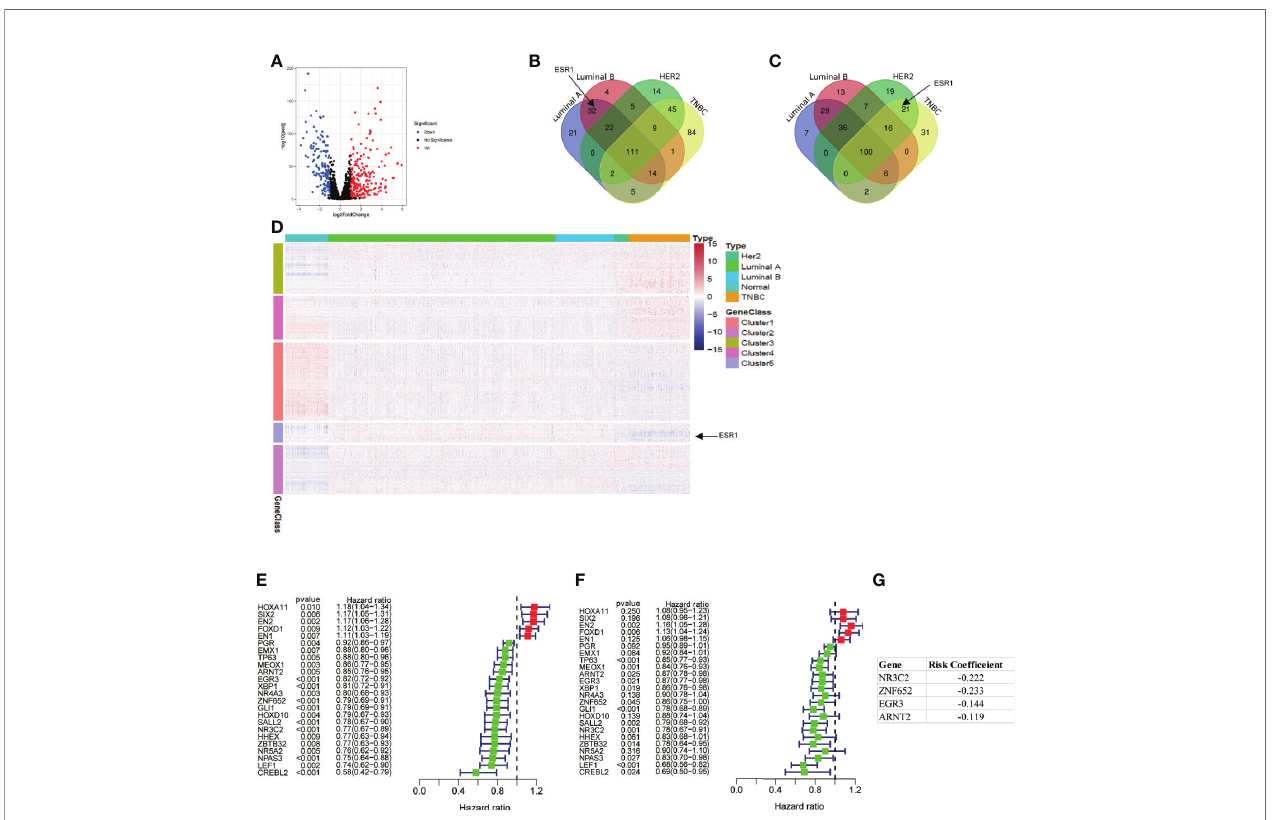
FIGURE 2 | Differentially expressed TFs and construction of a prognostic signature. (A) Volcano plot of 1639 TFs between breast cancer sample and normal breast sample using TCGA data. (B) Venn plot of upregulated TFs in different subtype of breast cancer. (C) Venn plot of downregulated TFs in different subtype of breast cancer. (D) Heatmap of all differentially expressed TFs. (E, F) Univariate Cox regression analysis of differentially expressed TFs regarding PFI and OS. (G) 4 TFs based risk score generated by multivariate Cox regression